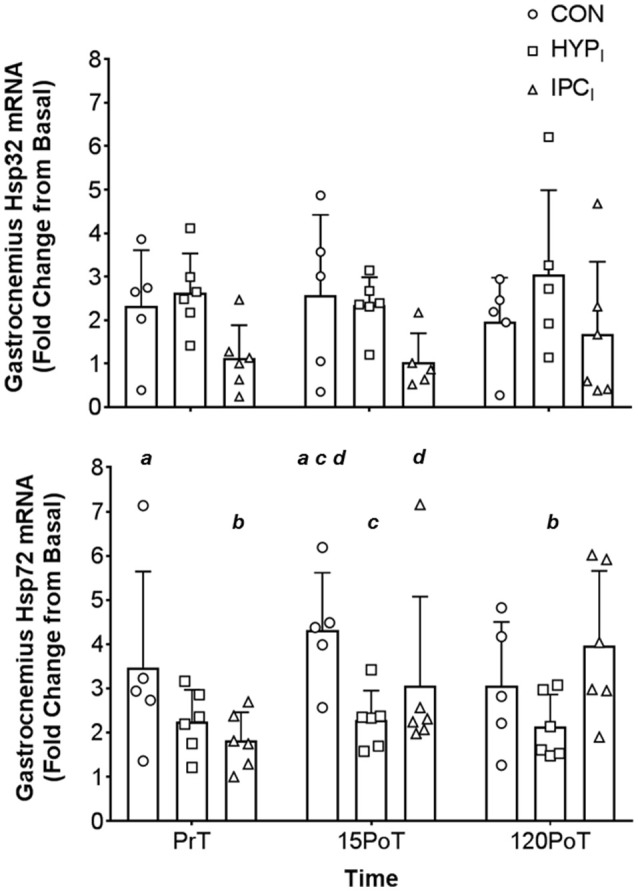
Mean (SD) gastrocnemius Hsp32 mRNA (top) and Hsp72 mRNA (bottom) expression. Gastrocnemius samples were obtained from CON (n = 5), HPCI (n = 6), and IPCI (n = 6) immediately pre-tourniquet application (PrT), 15 min post-tourniquet removal (15PoT), and 120 min post-tourniquet removal (120PoT). All experimental samples were expressed relative to a laboratory control gastrocnemius sample (from Basal). Letters (a, b, c, d) denote significant differences between corresponding letter (p < 0.05).